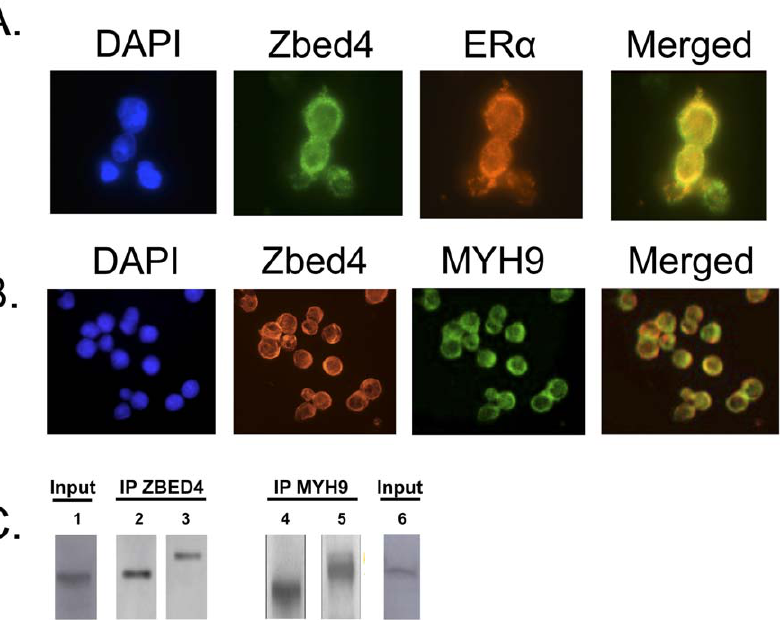
Figure 8. Co-localization of Zbed4 with ER a and MYH9 in Y79 retinoblastoma cells, carried out as described in Materials and Methods. The immunostaining results indicate that both ER a and MYH9 co-localize with Zbed4 in these cells. The major difference is that in A co- localization is seen in the nuclei and cytoplasm for Zbed4 and ER a whereas in B it is only observed in the cytoplasm for Zbed4 and MYH9. C. Immunoprecipitation experiments were carried out as in Figure 7C with Y79 retinoblastoma cells (Input, lanes 1 and 6) but using antibodies against Zbed4 (lanes 1, 2 and 4) or MYH9 (lanes 3, 5 and 6) instead; both Zbed4 and MYH9 are detected in each immunoprecipitate.